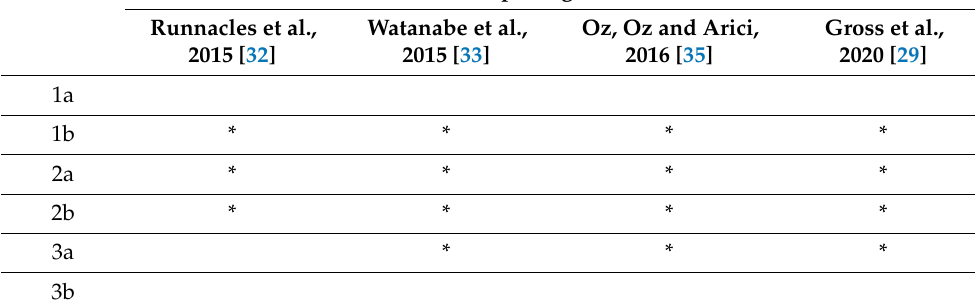
Table 4. Results of the assessment of in vivo studies by the use of the CONSORT 2010 checklist [26]. Cells marked with an asterisk “*” represent study fulfilment for the given quality assessment parameter. Cells left blank represent